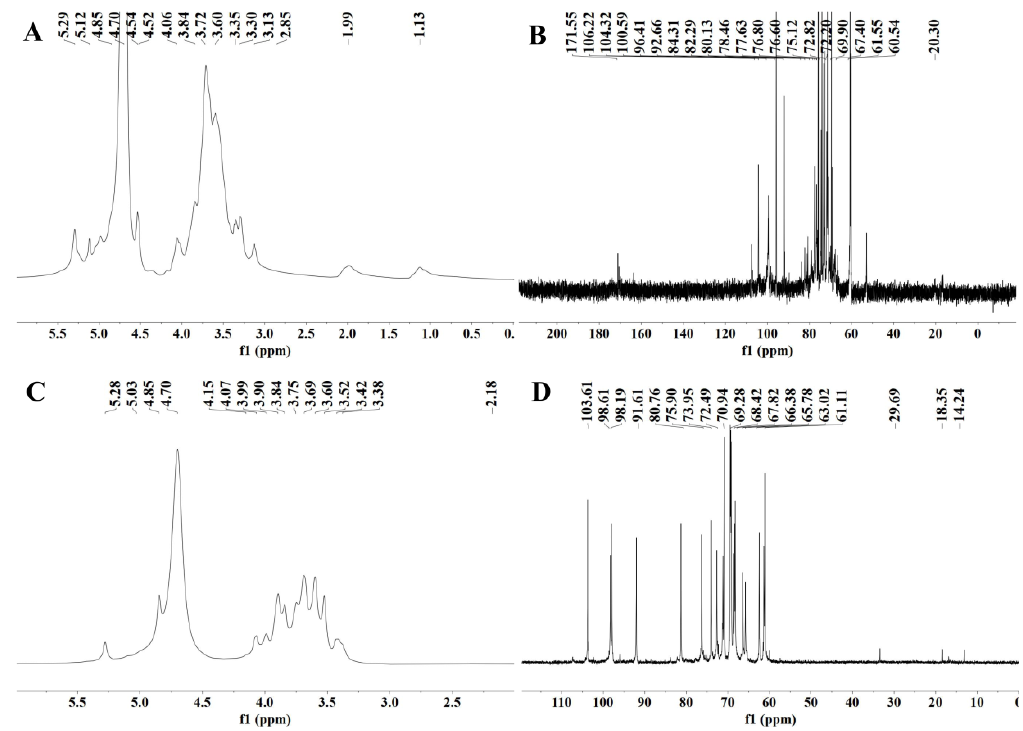
Figure 4. NMR spectra of two Rehmannia glutinosa polysaccharides. ( A ) 1 H spectrum of RGP − 1 − A; ( B ) 13 C spectrum of RGP − 1 − A; ( C ) 1 H spectrum of RGP − 2 − A; ( D ) 13 C spectrum of RGP − 2 − A. RGP − 1 − A: Rehmannia glutinosa polysaccharide decolorized by AB-8 macroporous resin, RGP − 2 − A: I polysaccharide decolorized by H 2 O 2 .